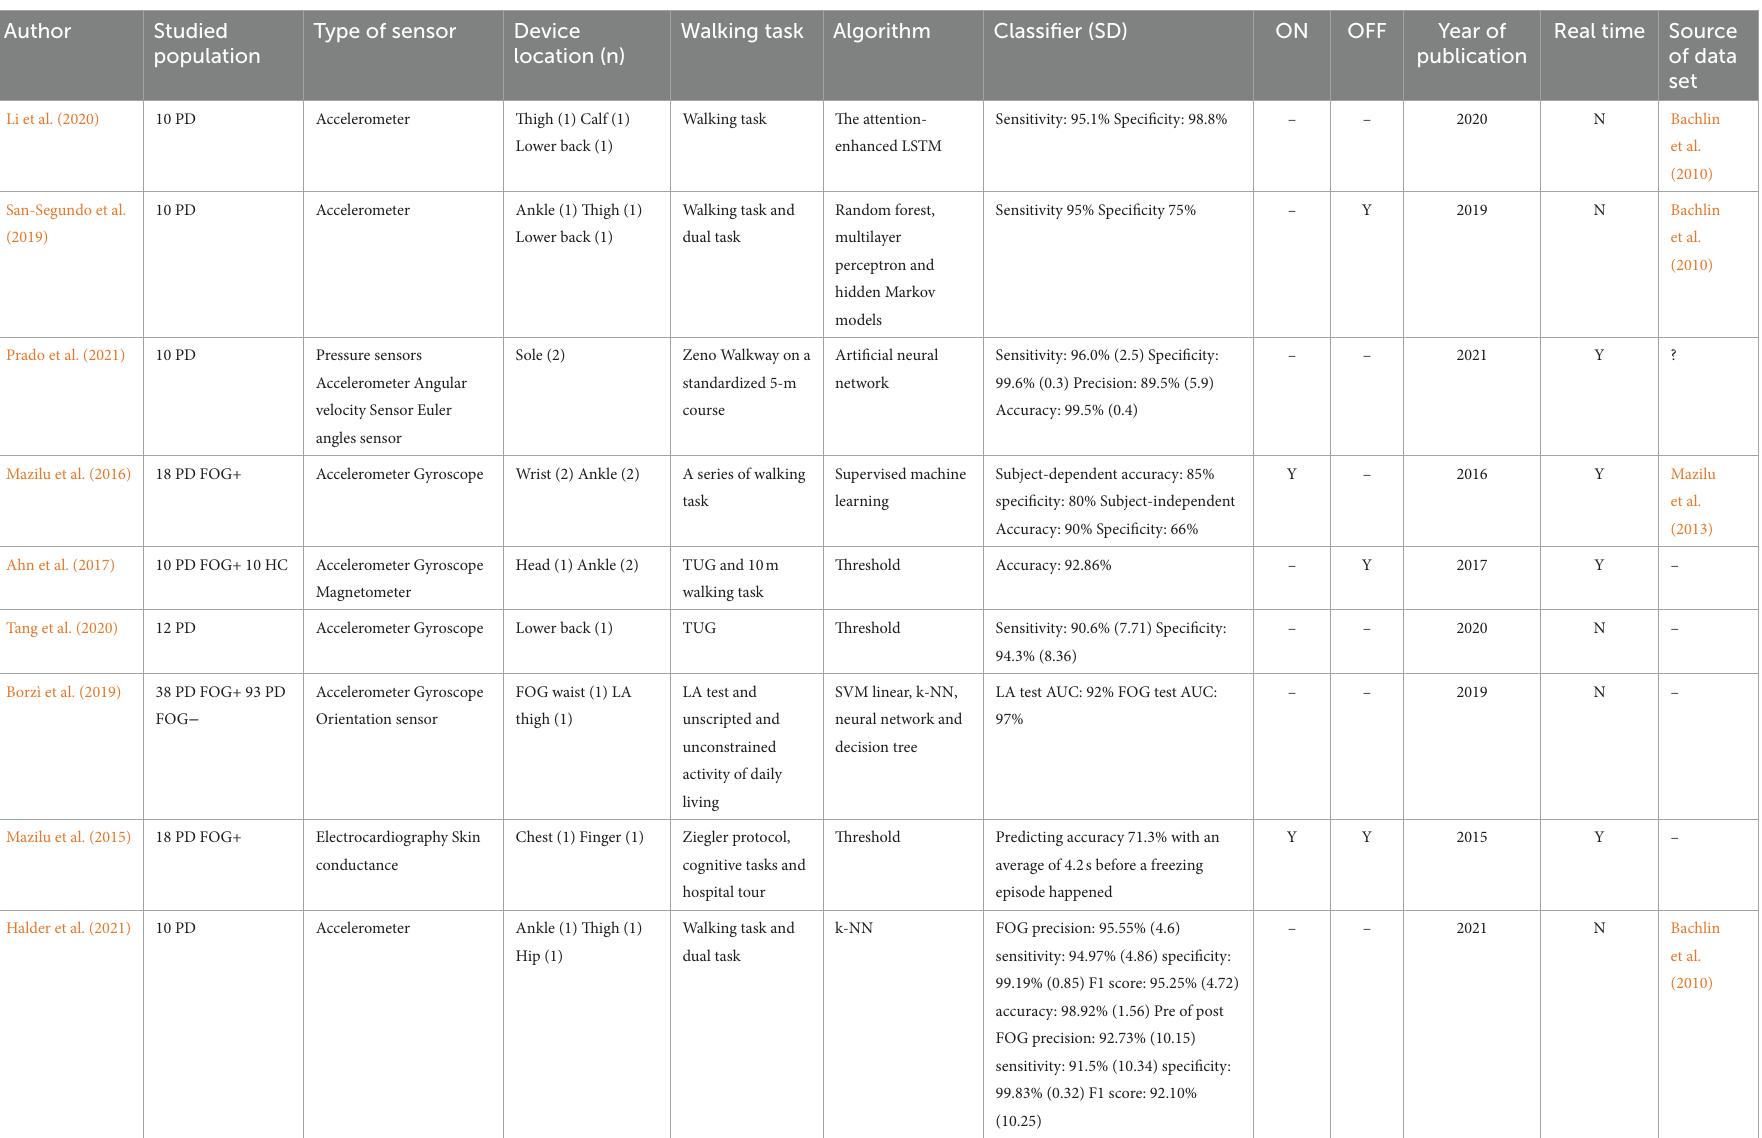
TABLE 2 Summary of FOG detection